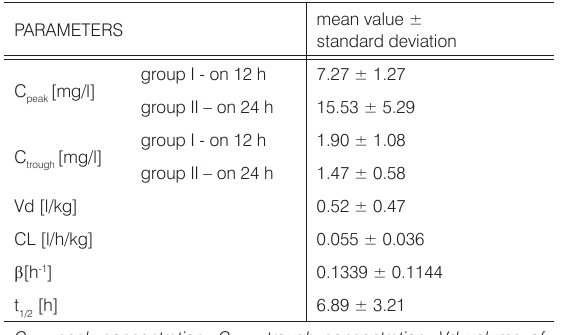
Table 2. Gentamicin concentrations and pharmacokinetic param- eters